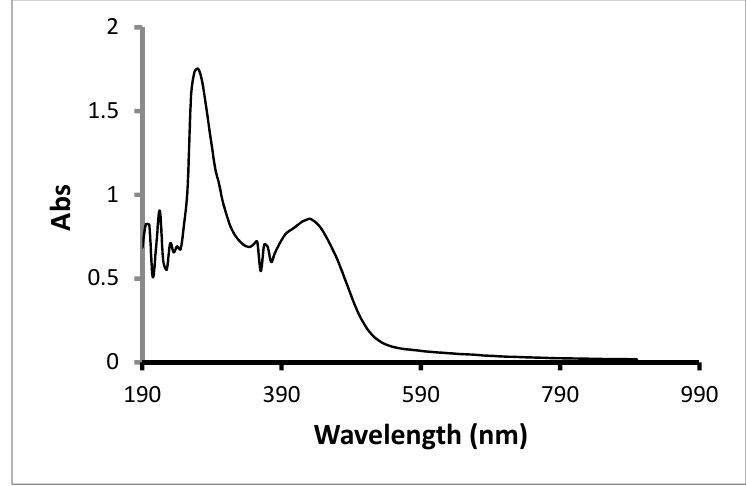
Figure 8. UV-Vis spectrum of the synthesized bismuth nanoparticles.